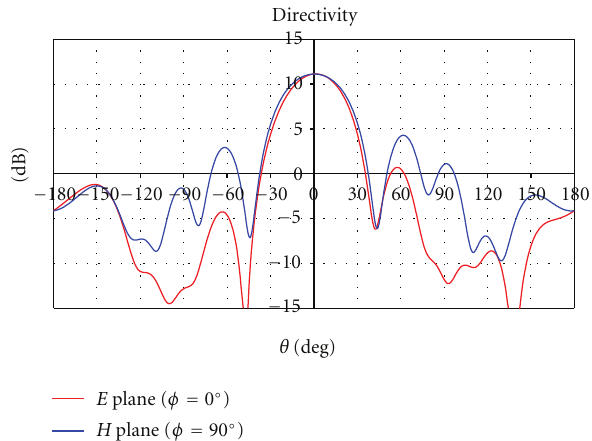
Figure 33: Prototype of the Yagi-Uda antenna including the SMD inductors and